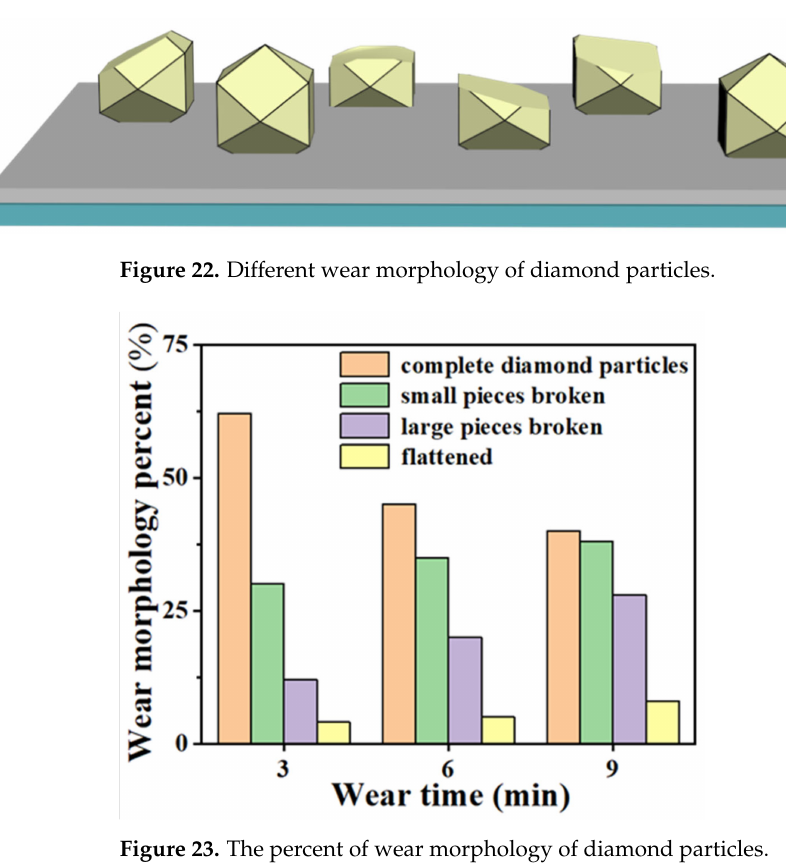
Figure 23. The percent of wear morphology of diamond